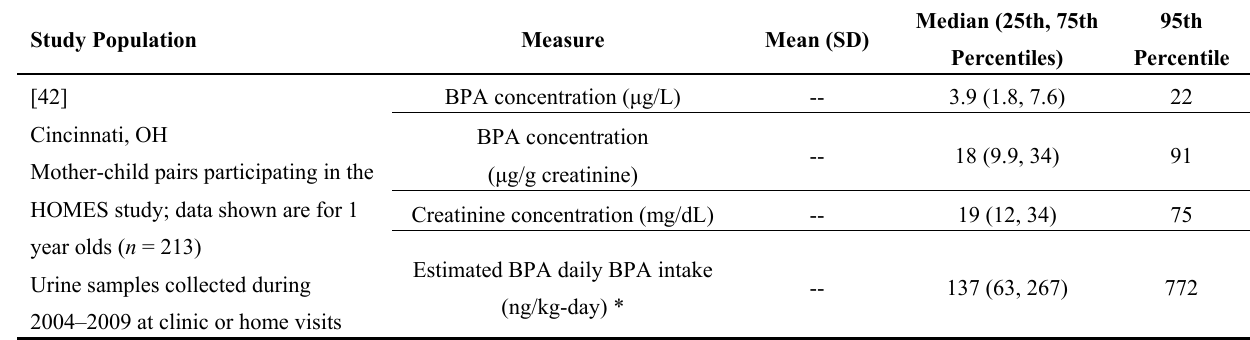
Table A7. BPA urine concentrations and estimated daily excretions based on published studies among